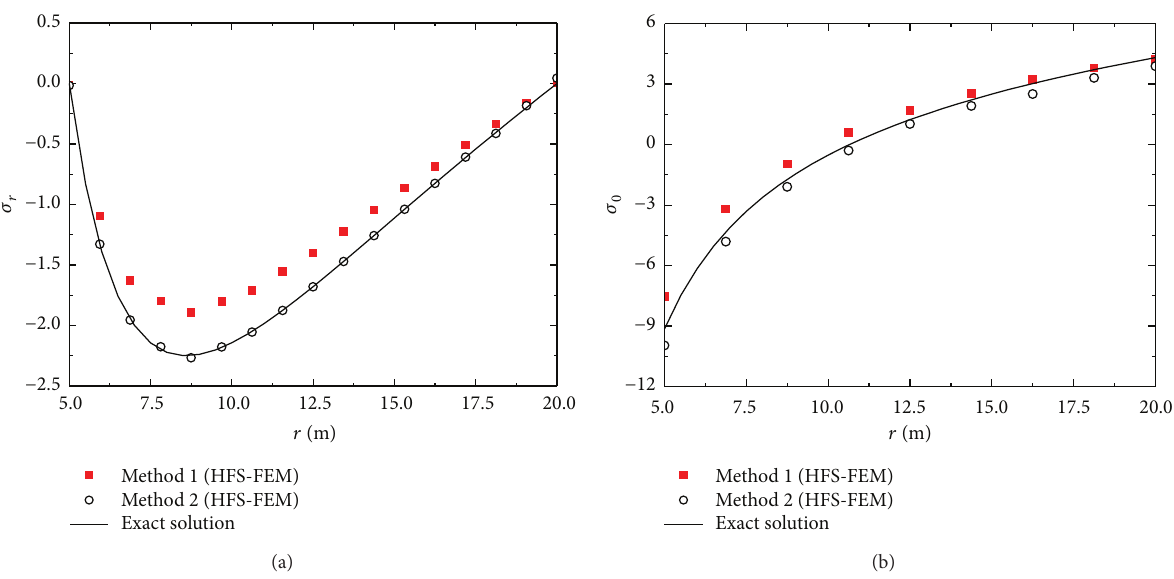
Figure 13: (a) Radial thermal stresses and (b) circumferential thermal stresses with the cylinder radius.